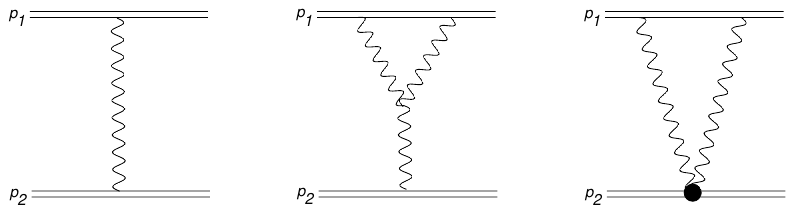
Figure 4 . Selection of 1PM diagrams arising from the VEV of GWLs in eq. (5.9). All vertices are eikonal, while the blob represents a next-to-eikonal vertex. Only the leftmost diagram contributes to the eikonal phase. All diagrams contribute to the Regge trajectory of the graviton. The dashed line splits each Wilson line in two branches corresponding to the initial and final states of the leading order amplitude. In position space, this affects the limits of integration over the position of the GWL vertices.